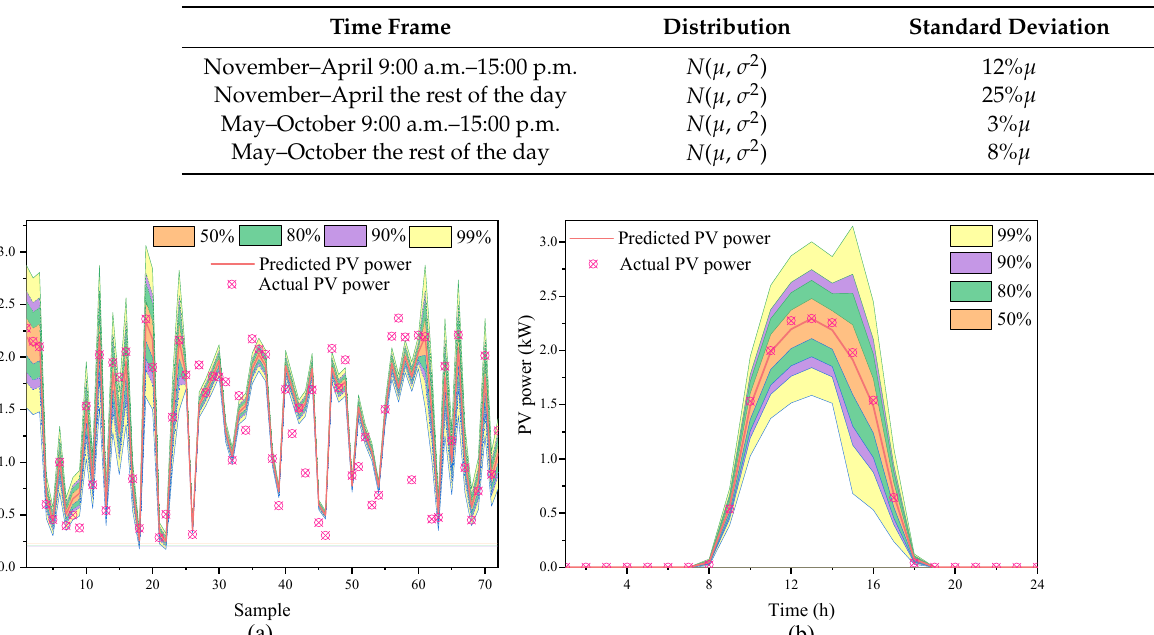
Figure 15. Confidence intervals under normal distribution. ( a ) Confidence intervals for time period of 11–12 h; ( b ) confidence intervals of a typical day in March.